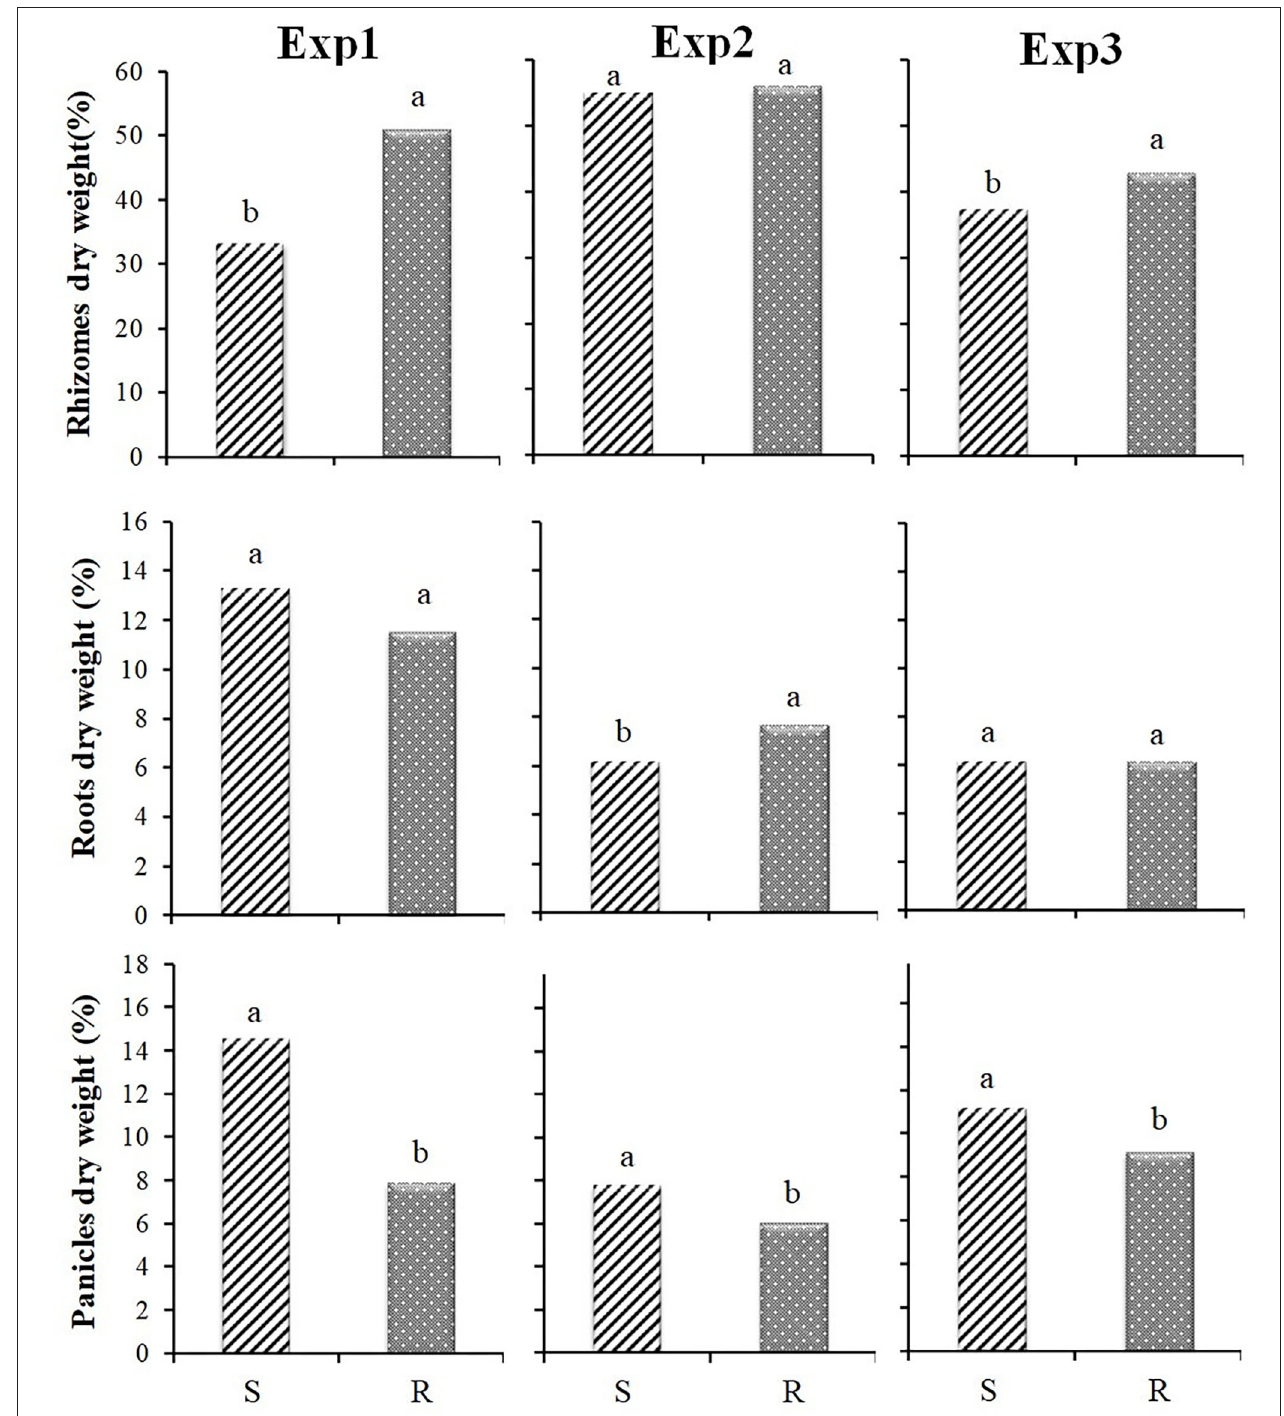
FIGURE 5 | Percentage of biomass allocated to different plant parts at the final harvest by plants S and R in relation to the total biomass for the three experiments: rhizomes, roots and panicles. Different letters indicate significant differences ( P ≤ 0.05) separated by Fisher’s LSD test.